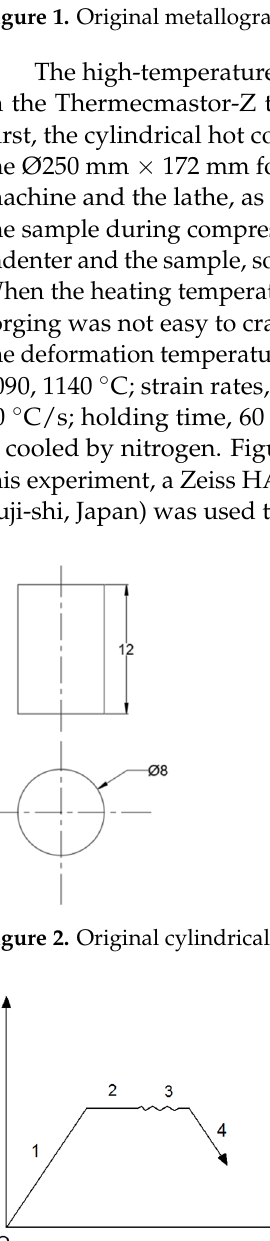
Figure 3. Flow chart of isothermal compression.